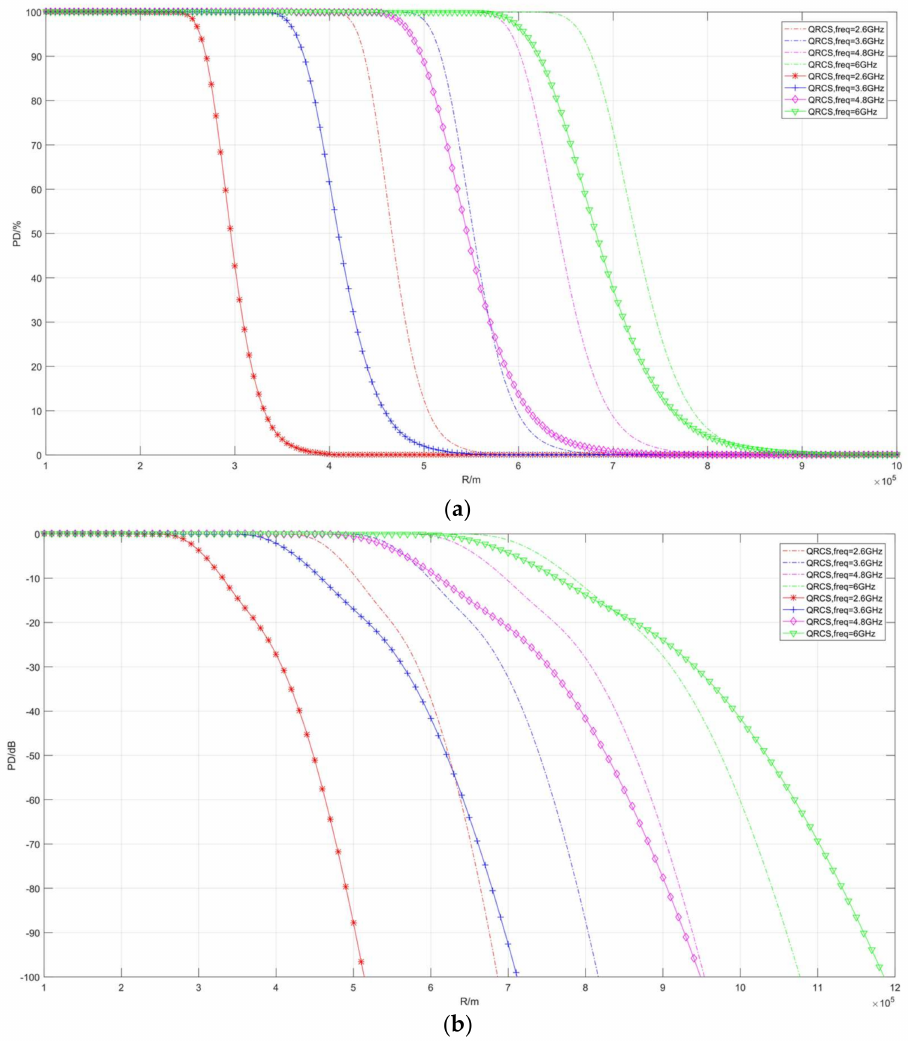
Figure 11. Correlation diagram of detection probability changing with distance (taking different frequencies) . ( a ) P D /%, ( b ) P D